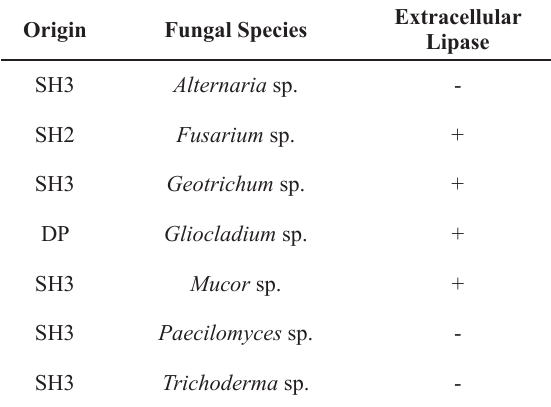
Lipase enzymatic activity of filamentous fungi obtained from effluents of dairy products and